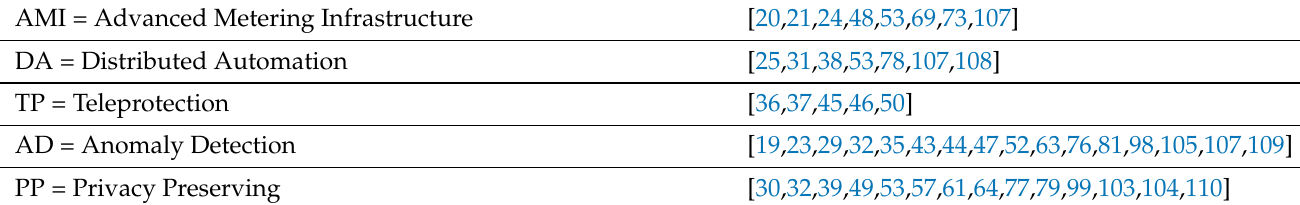
Table 6. Articles that can be classified by means of their applications.